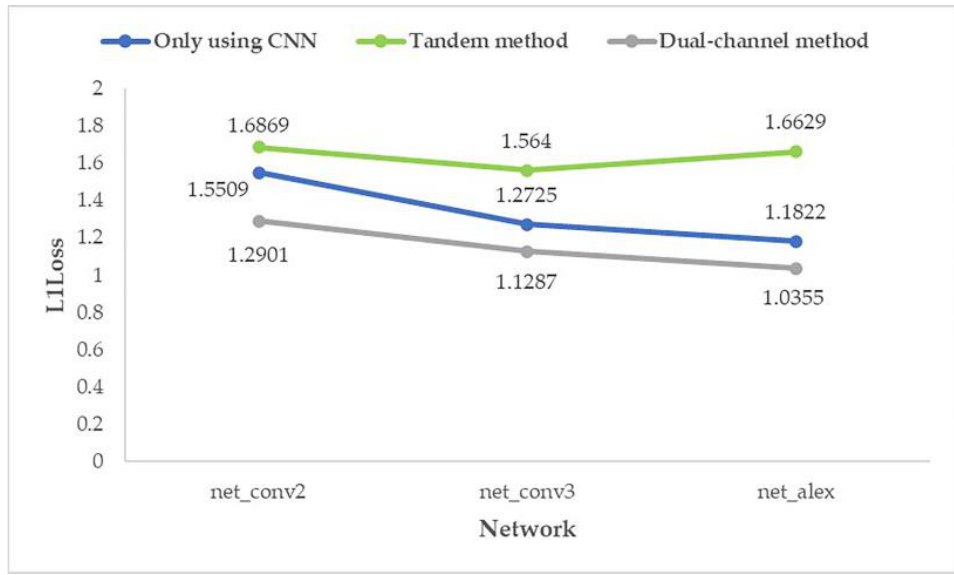
Figure 18. Average prediction loss of five parameters with random seed 0.